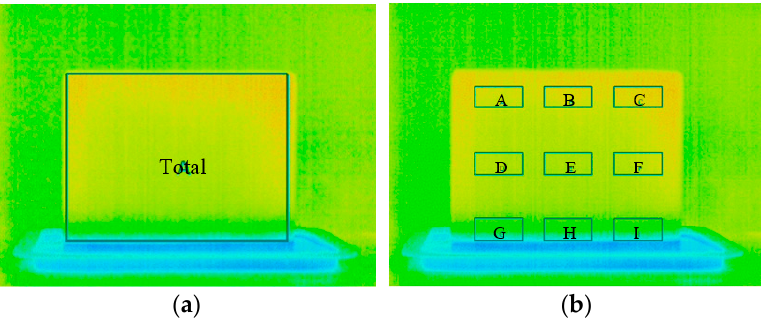
Figure 3. Definition of the boxes used: ( a ) box limiting the entire specimen with 189 × 143 pixels (for step I); ( b ) nine identical boxes with 42 × 19 pixels defined on the images (for step II).